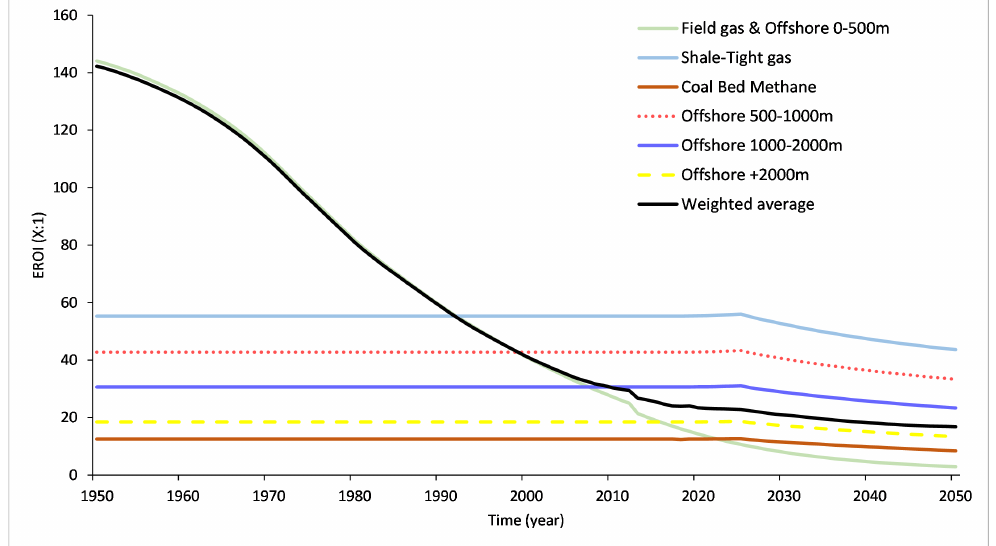
Figure 2. Evolution of the EROI of all gas types, and the weighted average from 1950 to 2050. The energy required for the production of gases grows from 1.3 EJ in 1990 to 11 EJ in 2020 and 53 EJ in 2050, showing an exponential increase until the curve starts to flatten from 2040. This respectively represents 1.7%, 6.3% and 23.7% of the gross energy production,